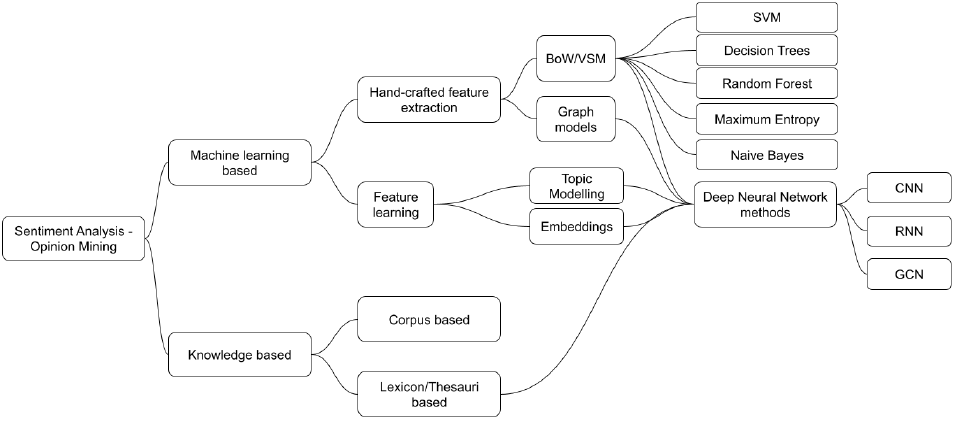
Figure 1. An overview of the techniques, algorithms, and models used for sentiment analysis and opinion